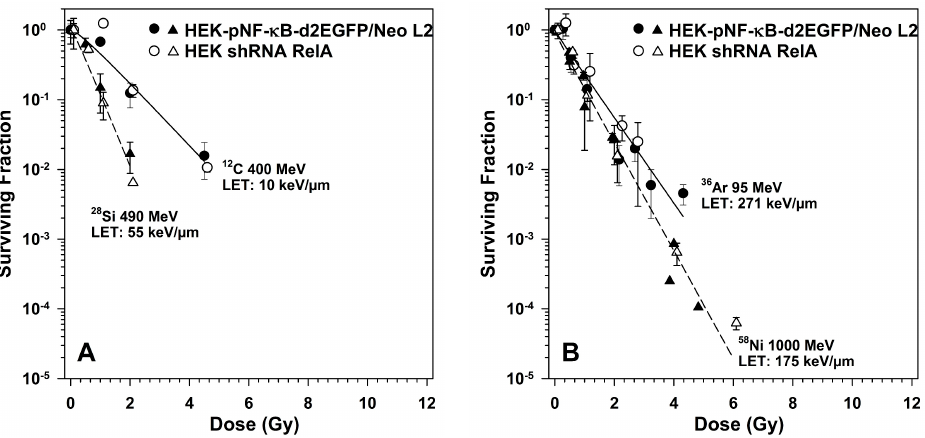
Figure 7. Clonogenic survival of HEK cells with RelA knock-down compared to the parental cells after exposure to heavy ions of diffent LET ( A ), linear energy transfer (LET) < 100 keV/µm, ( B ) LET > 100 keV/µm). HEK-pNF- κ B-d2EGFP/Neo L2 and HEK shRNA RelA cells were irradiated, incubated